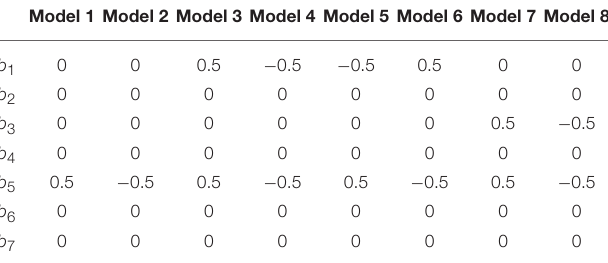
TABLE 1 | Slope parameters manipulated in the simulation